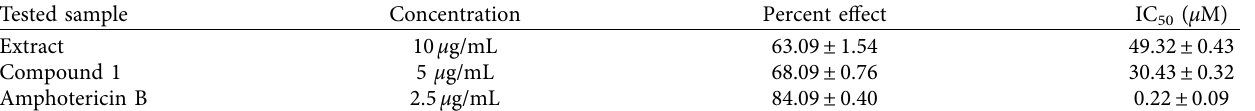
Table 1: Leishmanicidal activity of the extract and isolated flavonoid (1) from P. integerrima . Tested sample